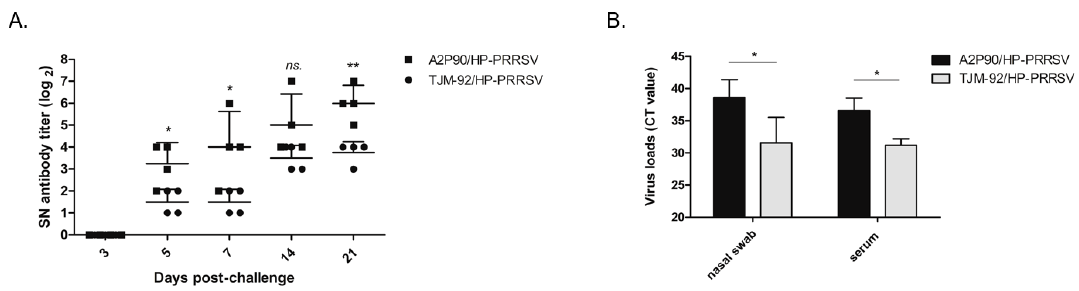
Figure 5. PRRSV-A2MC2-P90 vaccination evoked a higher titer of neutralizing antibodies in vaccinated piglets that correlated with reduced virus shedding and viremia. ( A ). Serum samples from piglets in the PRRSV-A2MC2-P90-vaccinated group (A2P90/HP-PRRSV) or TJM F92-vaccinated group (TJM-92/HP-PRRSV) were collected at indicated dpc after HP-PRRSV challenge. Sera